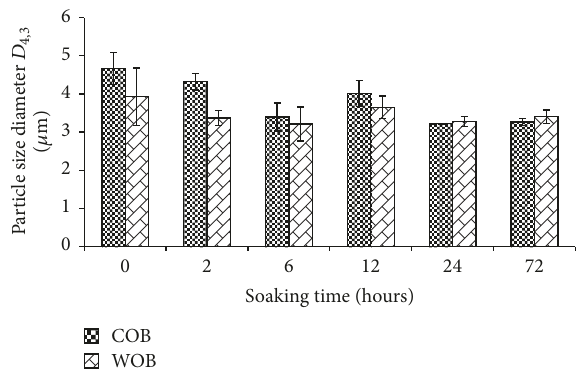
Figure 1: Average particle sizes of both crude oil body (COBs) and washed oil body (WOBs) emulsions at different seed presoaking